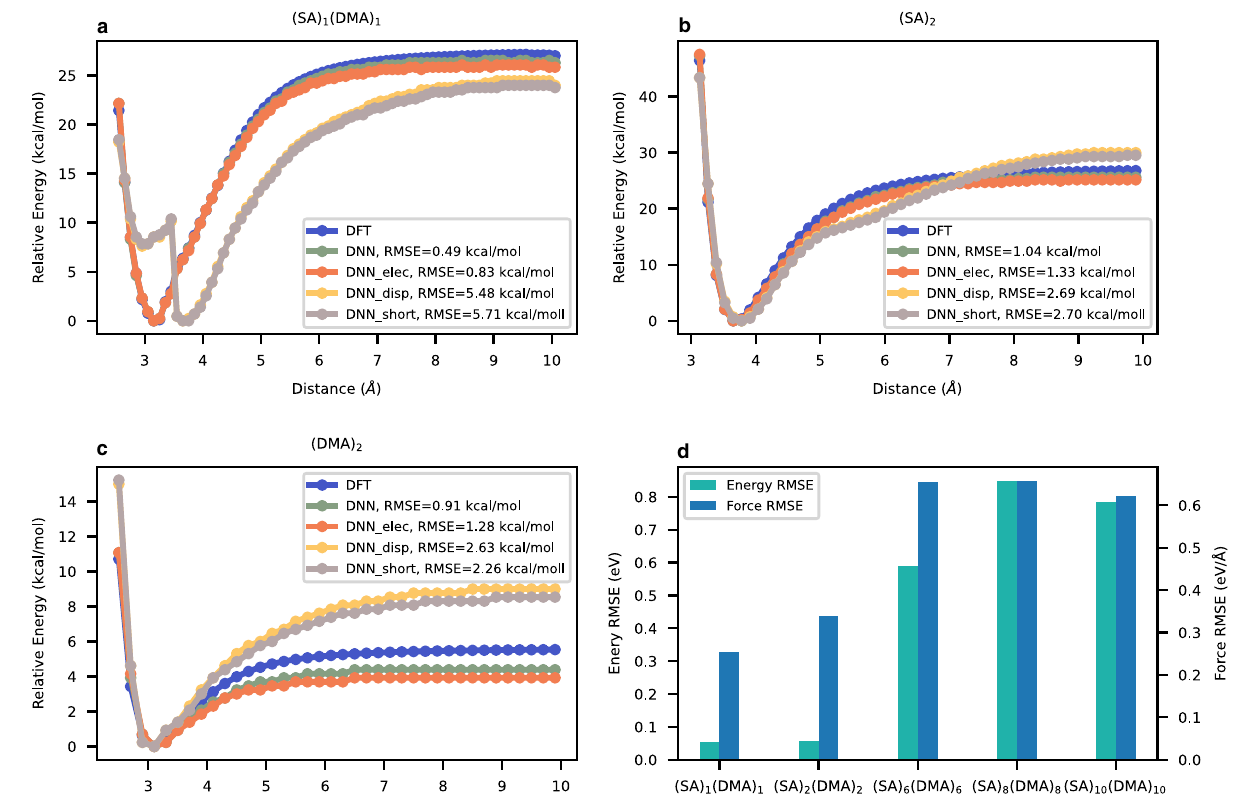
Fig. 2 | Deep neural network-based force fi eld (DNN-FF) benchmark. a – c show the dimer detachment curves for (SA) 1 (DMA) 1, (SA) 2 , and (DMA) 2 , respectively, where SA and DMA represent sulfuric acid and dimethylamine molecules, respec- tively.Therelativeenergyistheisomerenergyminustheenergyofthemoststable isomer. DNN, DNN_elec, DNN_disp, and DNN_short represent the model with